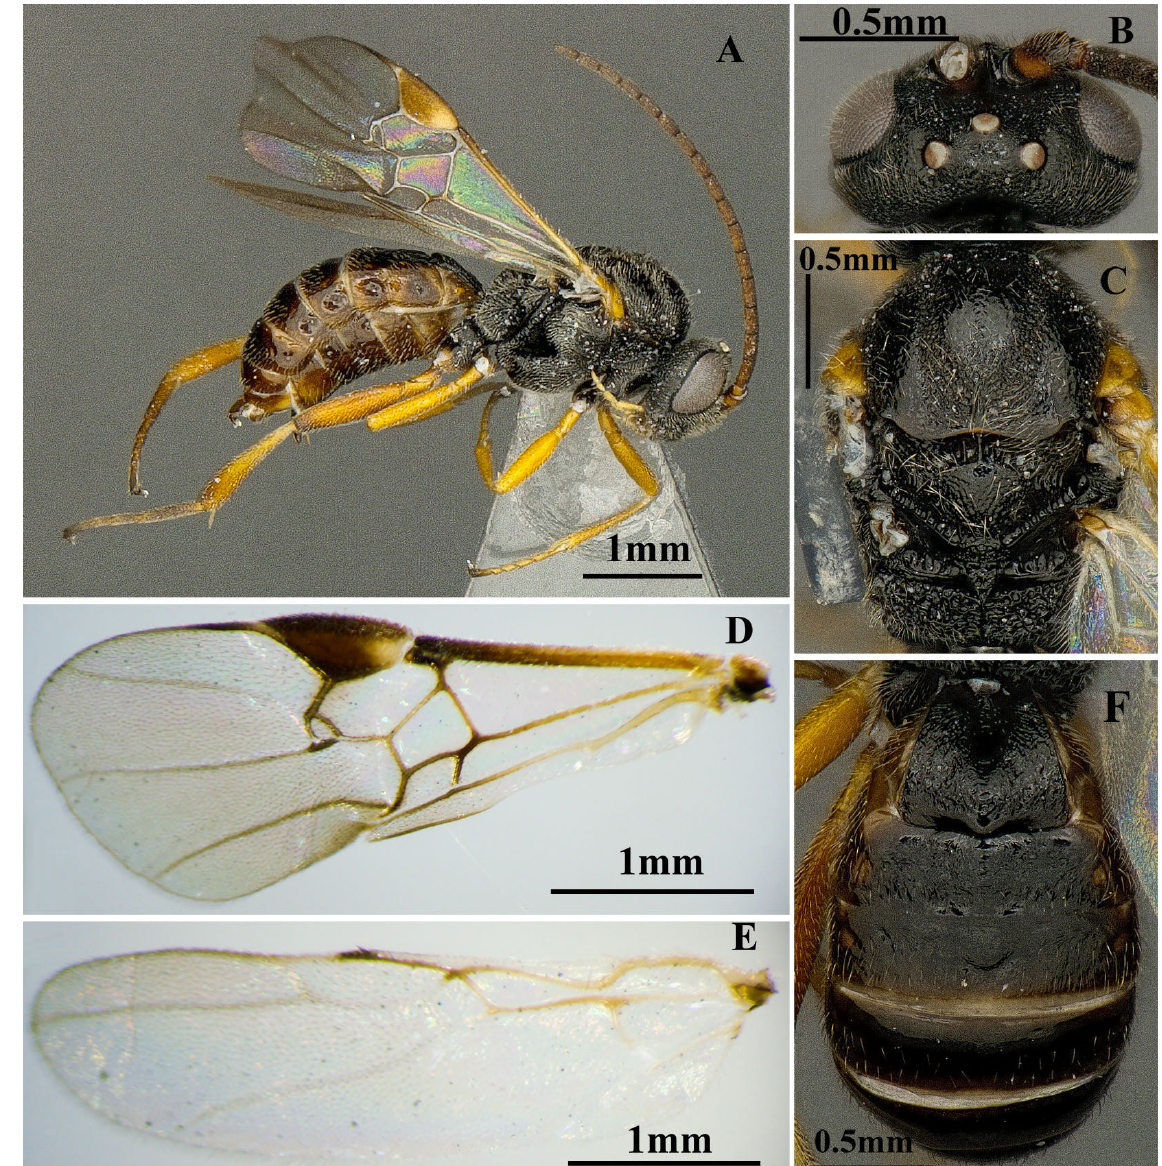
Fig. 9. Microplitis pallidipennis Tobias, 1964, ♀, TMUC-HBMMP0056. A . Habitus, lateral view. B . Head, dorsal view. C . Mesosoma, dorsal view. D . Fore wing. E . Hind wing. F . Metasoma, dorsal